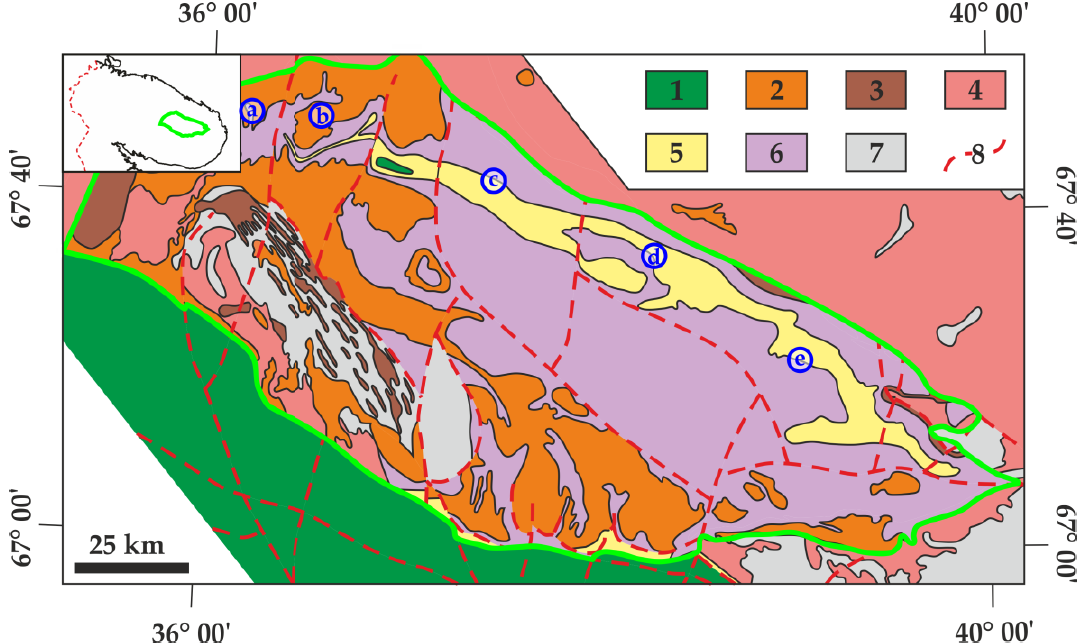
Figure 1. Geological scheme of the Keivy Terrane compiled on the basis of the 1:500,000 Geological Map of the Kola Region (simplified after Reference [13]), showing sampling locations (letters in blue circles): ( a )—Makzabak (sillimanite schists); ( b )—Rova (quartzolites); ( c )—Tyapshmanyuk (kyanite schists); ( d )—Shuururta (kyanite schists); ( e )—Igiurta (kyanite schists). Legend: 1—mafic and ultramafic rocks, PR1; 2—Keivy alkaline granite complex, AR2; 3—gabbroids, AR2; 4—granitoids of normal alkalinity (undivided), AR2; 5—Keivy series aluminous schists, AR2; 6—Tundra series rocks (acidic, medium, basic metavolcanics, mica parashists), AR2; 7—gneisses and amphibolites of Kola series (basement complex), AR; 8—faults. The green line delineates the boundaries of the Keivy Terrane. The inset shows the position of the Keivy Terrane within the Kola Peninsula.